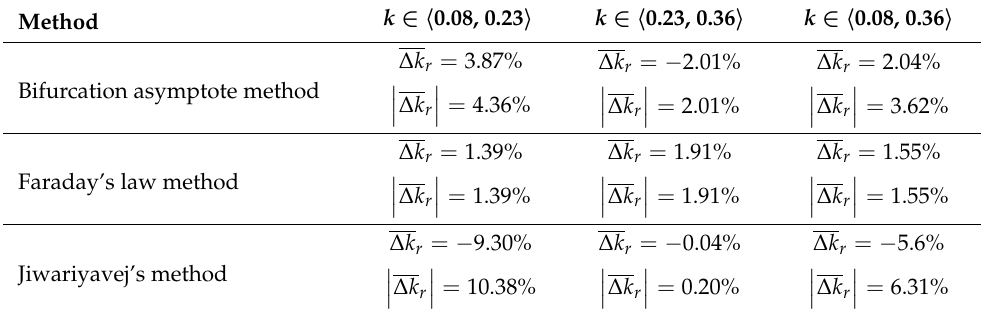
(cid:12) (cid:12) r (cid:12) of the evaluated